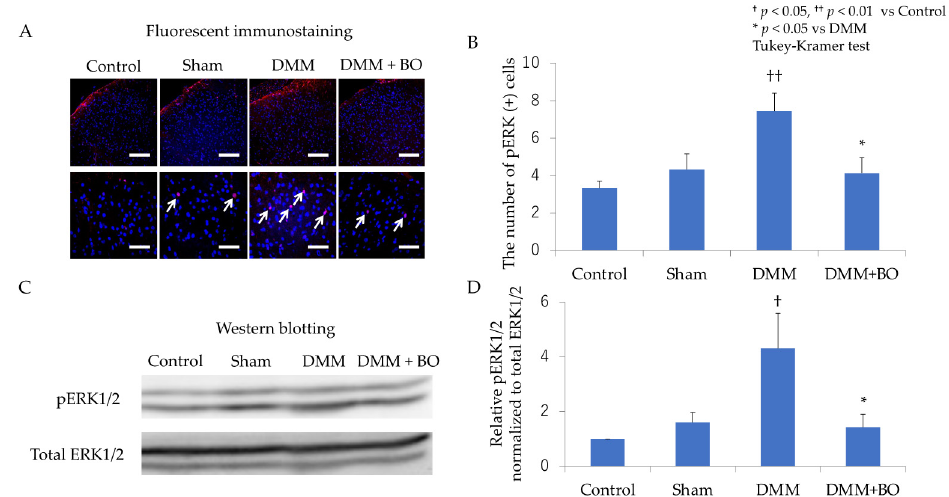
Figure 4. Expression of pERK1/2 in the right dorsal horn of the spinal cord in the acute phase (1 day after DMM surgery). ( A ) Representative images of immunofluorescence staining in each group (red; pERK1/2, blue; nucleus). Upper images; magnification: ×200, Scale bar = 150 µm. Lower images; magnification: ×600, Scale bar = 50 µm. White arrow ( ↗ (cid:0) ) indicates a pERK1/2- positive cell. ( B ) The numbers of pERK1/2-positive cells. Each n = 5, †† p < 0.01 vs. Control, * p < 0.05 vs. DMM. ( C ) Immunoblot images of pERK1/2 and total ERK1/2 in the right dorsal horn of the spinal cord. ( D ) The quantified data of the immunoblot for pERK1/2 normalized to total ERK1/2. Each n = 5, † p < 0.05 vs. control, * p < 0.05 vs. DMM. All data are presented as mean ± standard deviation. pERK, phosphorylated extracellular signal-regulated kinase; DMM, destabilization of the medial meniscus; BO, boiogito.